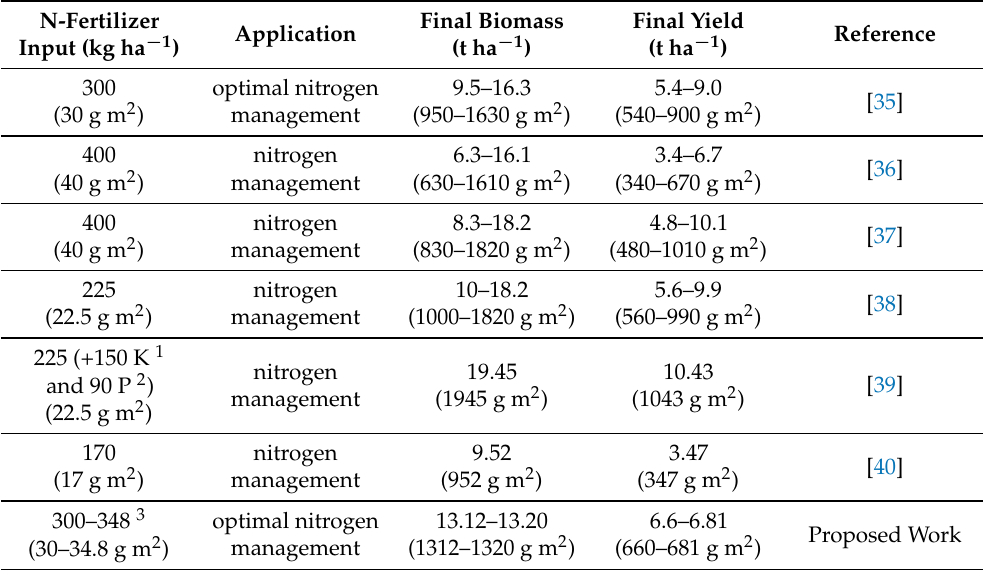
Table 5. Results